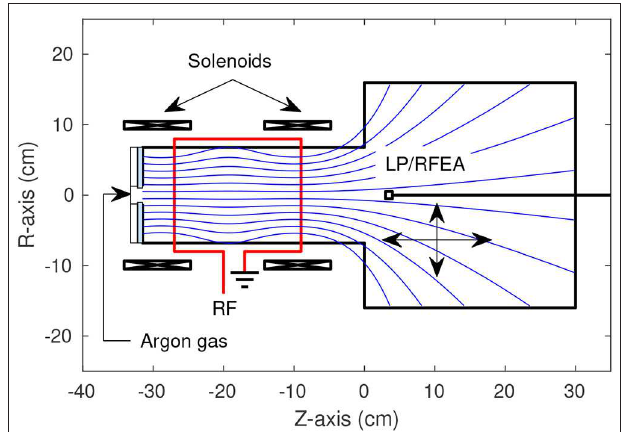
FIGURE 1 | Schematic of the Chi Kung reactor showing the locations of the solenoids, RF antenna, gas inlet, insulating glass plate in the source region and diagnostic probes. The magnetic field lines generated by the solenoids are pictured as blue lines. The Langmuir probe (LP) and retarding field energy analyzer (RFEA) possessed an axial range of − 20 ≤ Z ≤ 30 cm and a radial range of − 14 ≤ R ≤ 14 cm.